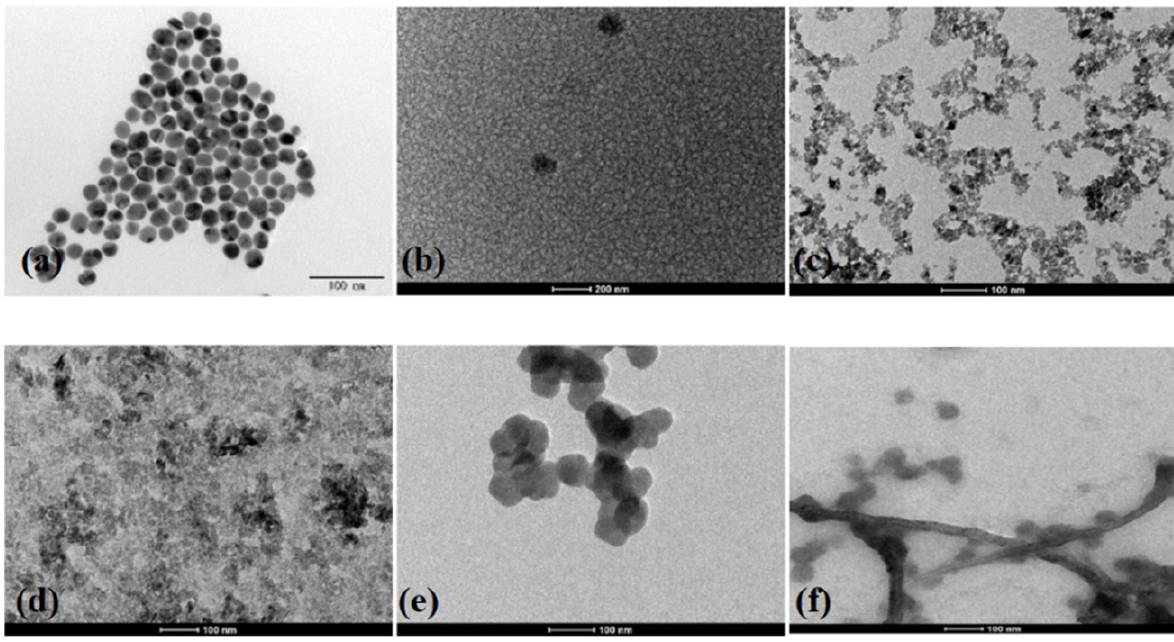
Figure 5. TEM image of Au − CuO hybrid nanofluid.